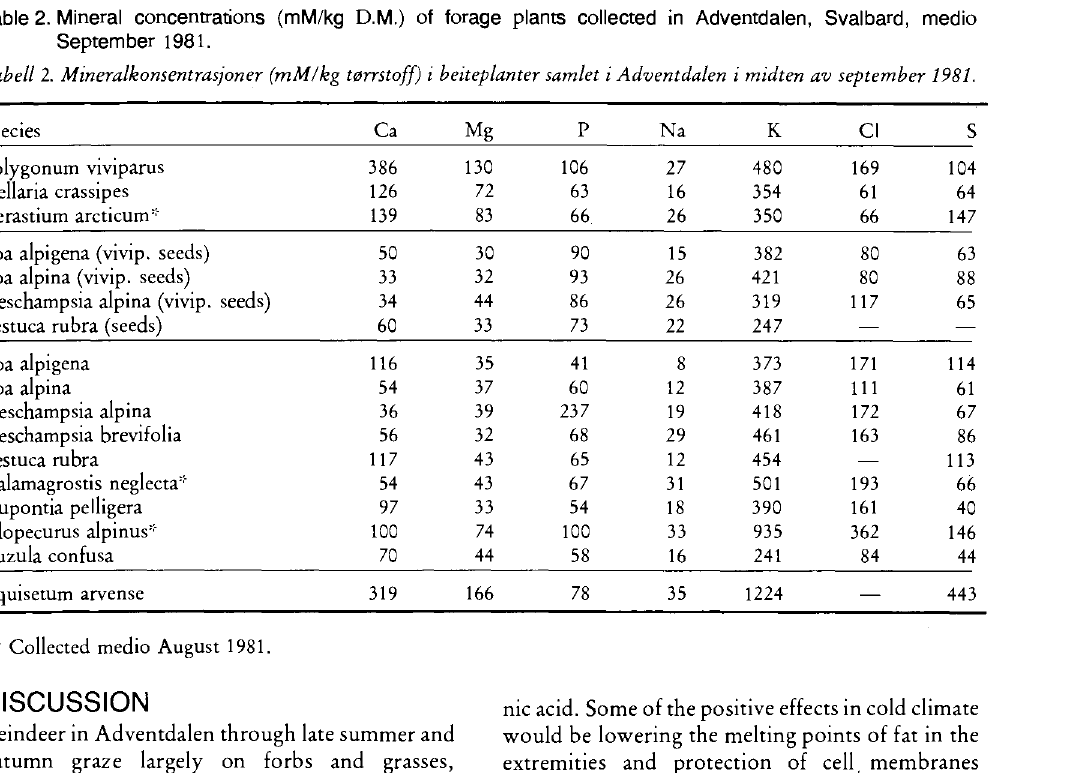
Table 2. Mineral concentrations (mM/kg D.M.) of forage plants collected in Adventdalen, Svalbard, medio September